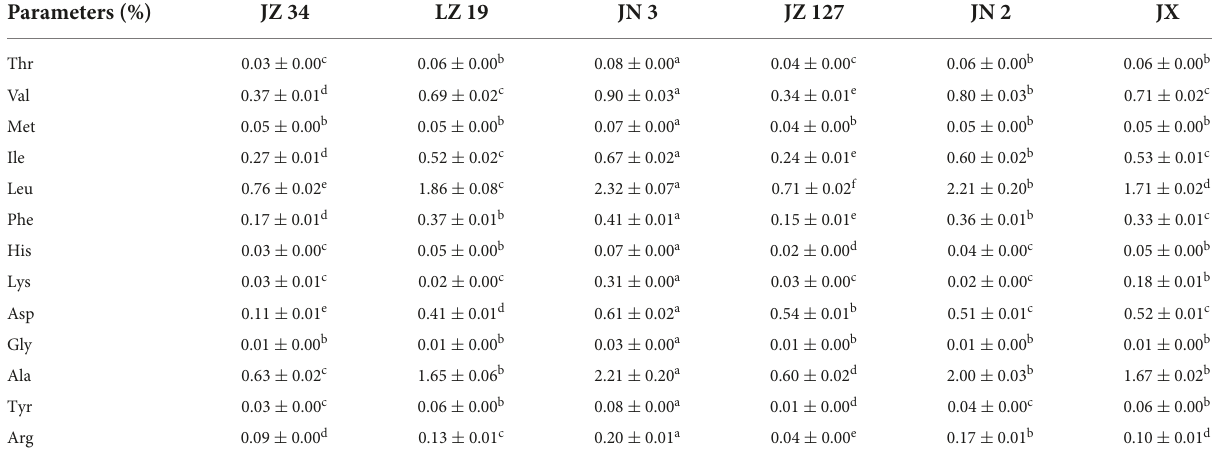
Data are representedas the mean ± SD of triplicatedeterminations. Along the same row, valueshaving different letter vary significantlydifferent ( p < 0.05). JZ 34,jinza 34; LZ 19, liaoza 19; JN 3, jinnuo 3; JZ 127, jiza 127; JN 2, Jiniang 2; JX, jiaxian. Thr, thereonine; Val, valine; Met, methionine; Ile, isoleucine; Leu, leucine; Phe, phenaylalanine; His, histidine; Lys, lysine;